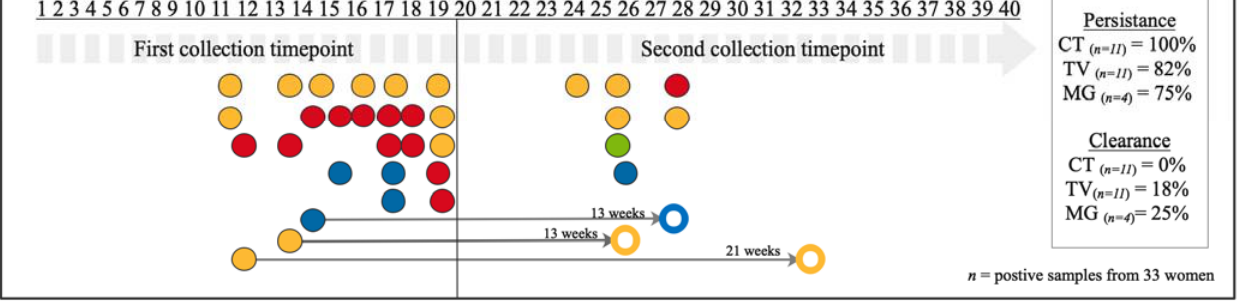
Figure 2. Schematic overview of the persistence and clearance of CT, NG, TV and MG genital infections of positive vaginal swabs collected during pregnancy ( n = 33 infected women out of 202 tested women). Horizontal labels indicate the time of collection in gestational age in weeks. Each dot represents a vaginal sample positive for C. trachomatis (in red), T. vaginalis (in yellow), N. gonorrhoeae (in green), and M. genitalium (in blue). Open dots represent cleared infections. The thin grey arrows, with the interval between testing in weeks on top, connect a positive sample with matching coloured open dot and it refers to cleared infections. The seven dots in the second collection timepoint period indicate samples with de novo infections (as samples from the same women collected earlier were not positive for the same pathogens). All infections detected at first timepoint did persist if no thin grey arrow was connected to them.